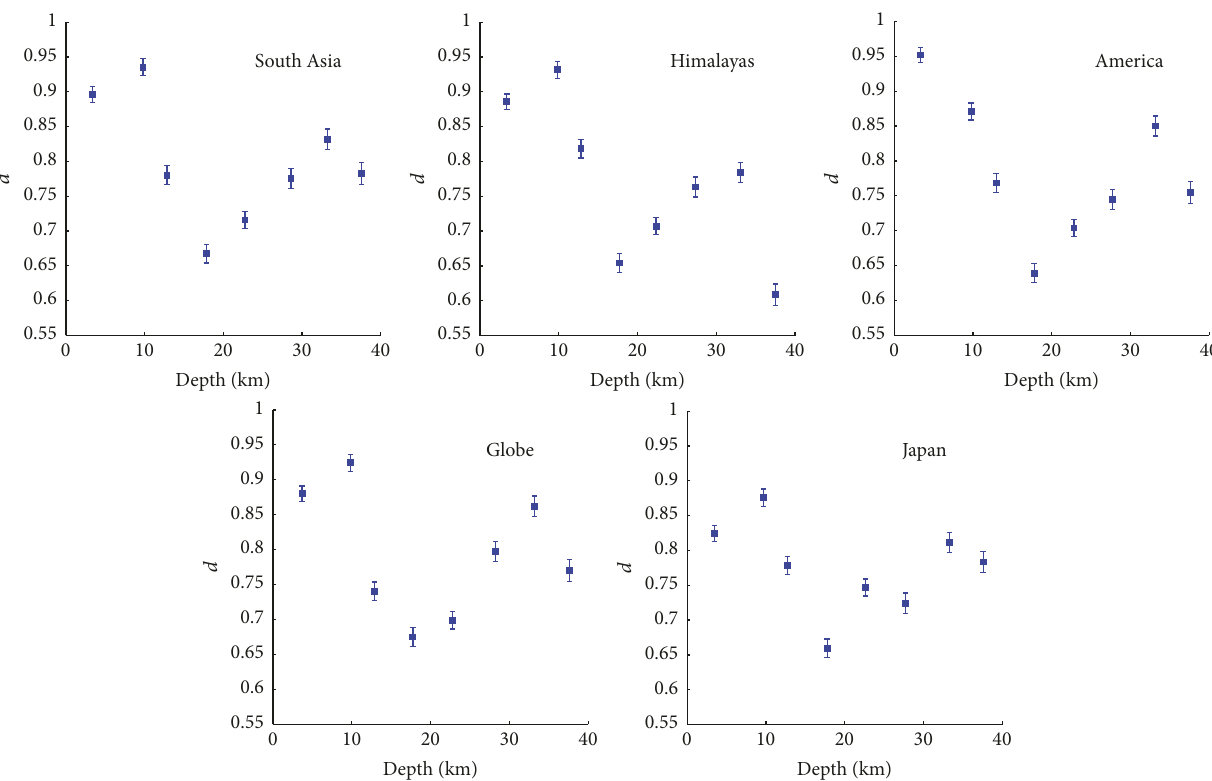
Figure 5: Variation with the depth of 𝑑 , calculated by the modified DFA for the time series of hypocenter separation distance in catalogs: South Asia, Himalayas, America, Globe, and Japan. Depth range is 0 − 40 km in 5 km class.